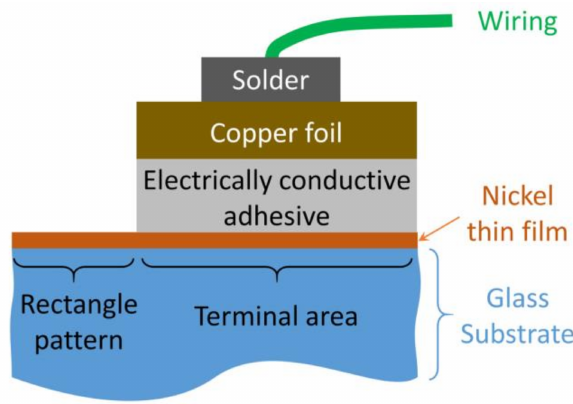
Figure 10. Wiring connection to the device terminal.